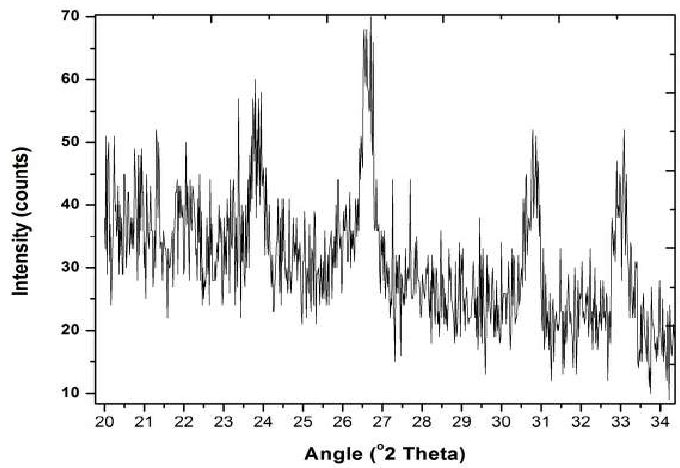
Figure 7. XRD of HEC/PANI-PPy.